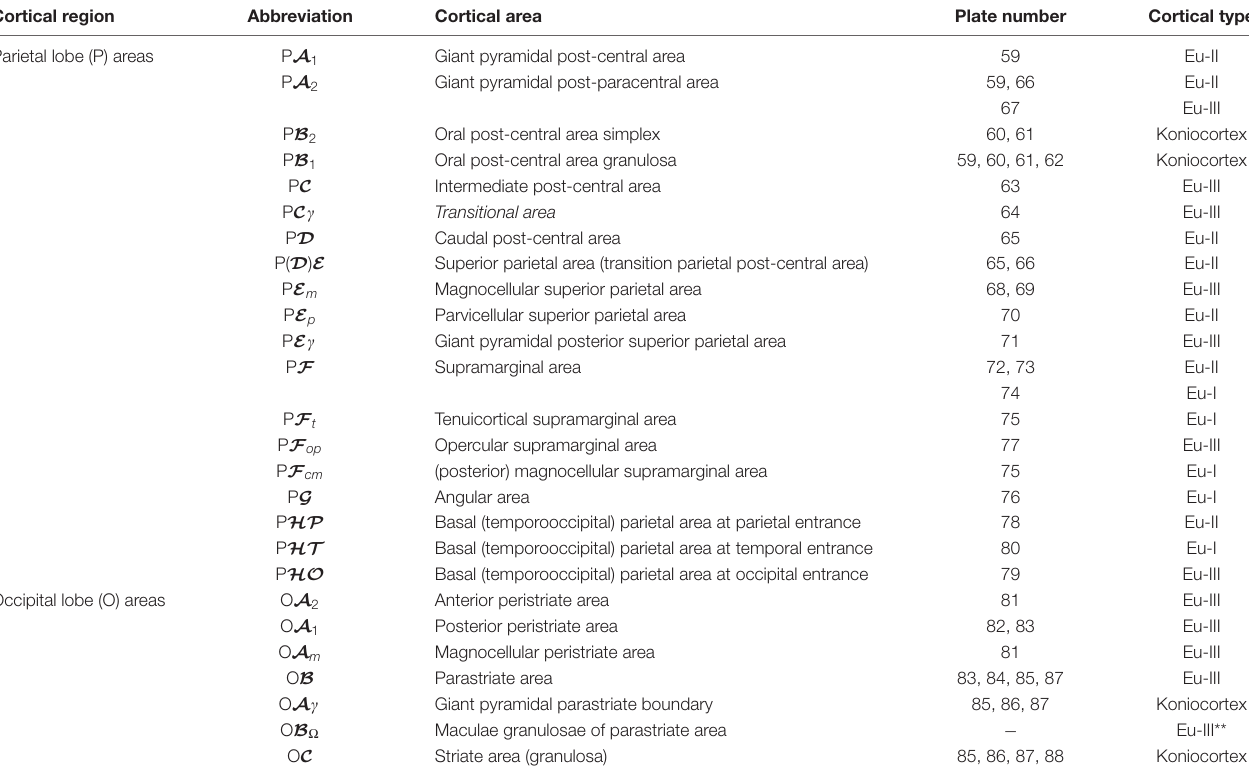
TABLE 7 | Areas in the human cerebral cortex according to von Economo and Koskinas (1925/2008) and their corresponding types: Parietal and occipital lobes. Cortical